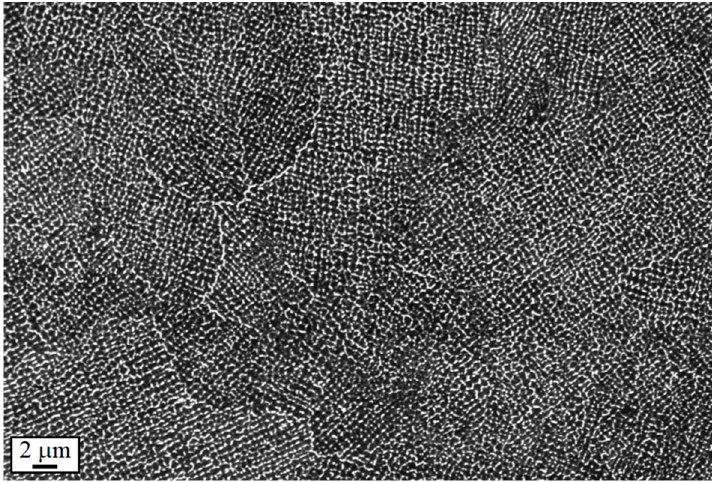
Figure 4. Microstructure of IN718 in the as-built state observed with secondary electron